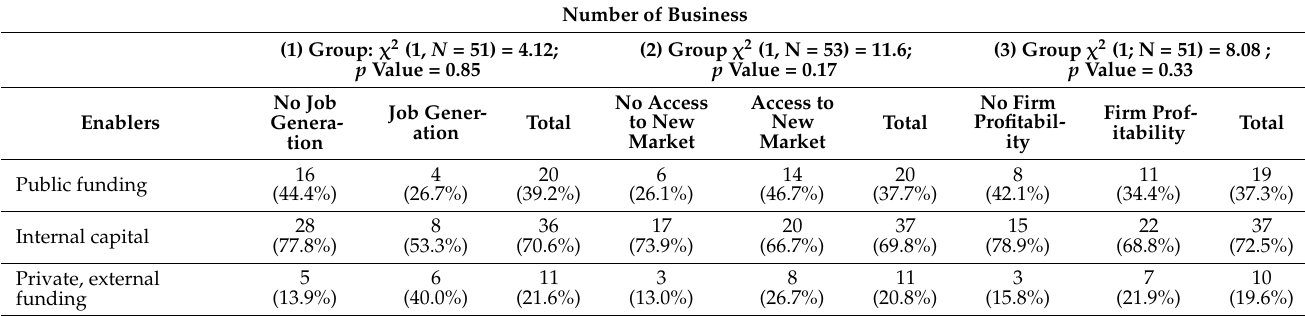
Table 3. Enablers of rural SMEs for supporting the adoption of the new technology. Number of